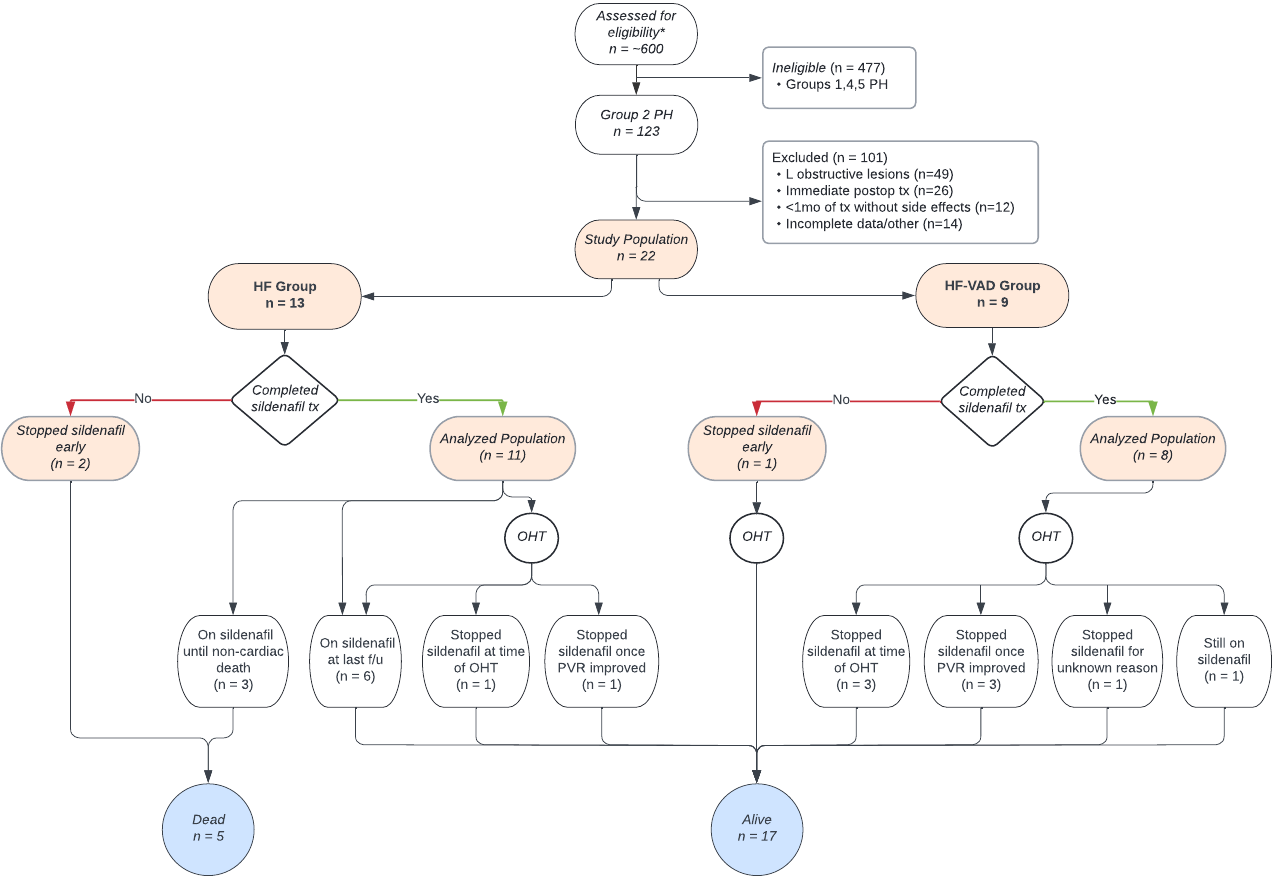
Figure 3. Patient selection, group allocation, and outcomes in the HF and HF-VAD groups. * Inclusion criteria: pediatric patients treated between 2007–2020 with Group 2 PH secondary to HF. Exclusion criteria: single ventricle/complex congenital patients, left-to-right shunts, lung disease, idiopathic PH, and Group 2 PH with left-sided obstructive lesions. Patients with right-sided mechanical support were